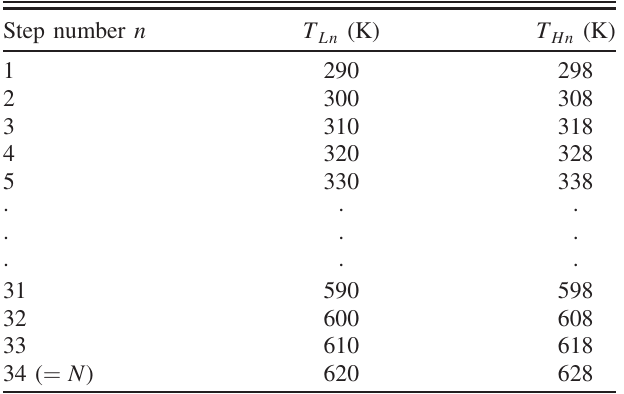
TABLE I. Set temperatures of the heat baths for each meas- urement step number n ð ≤ N Þ . Here, the T Hn and T Ln values are increased by 10 K with every n increase, while T Hn − T Ln is fixed at 8 K. The single dots represent the abbreviation of the n , T Hn , and T Ln